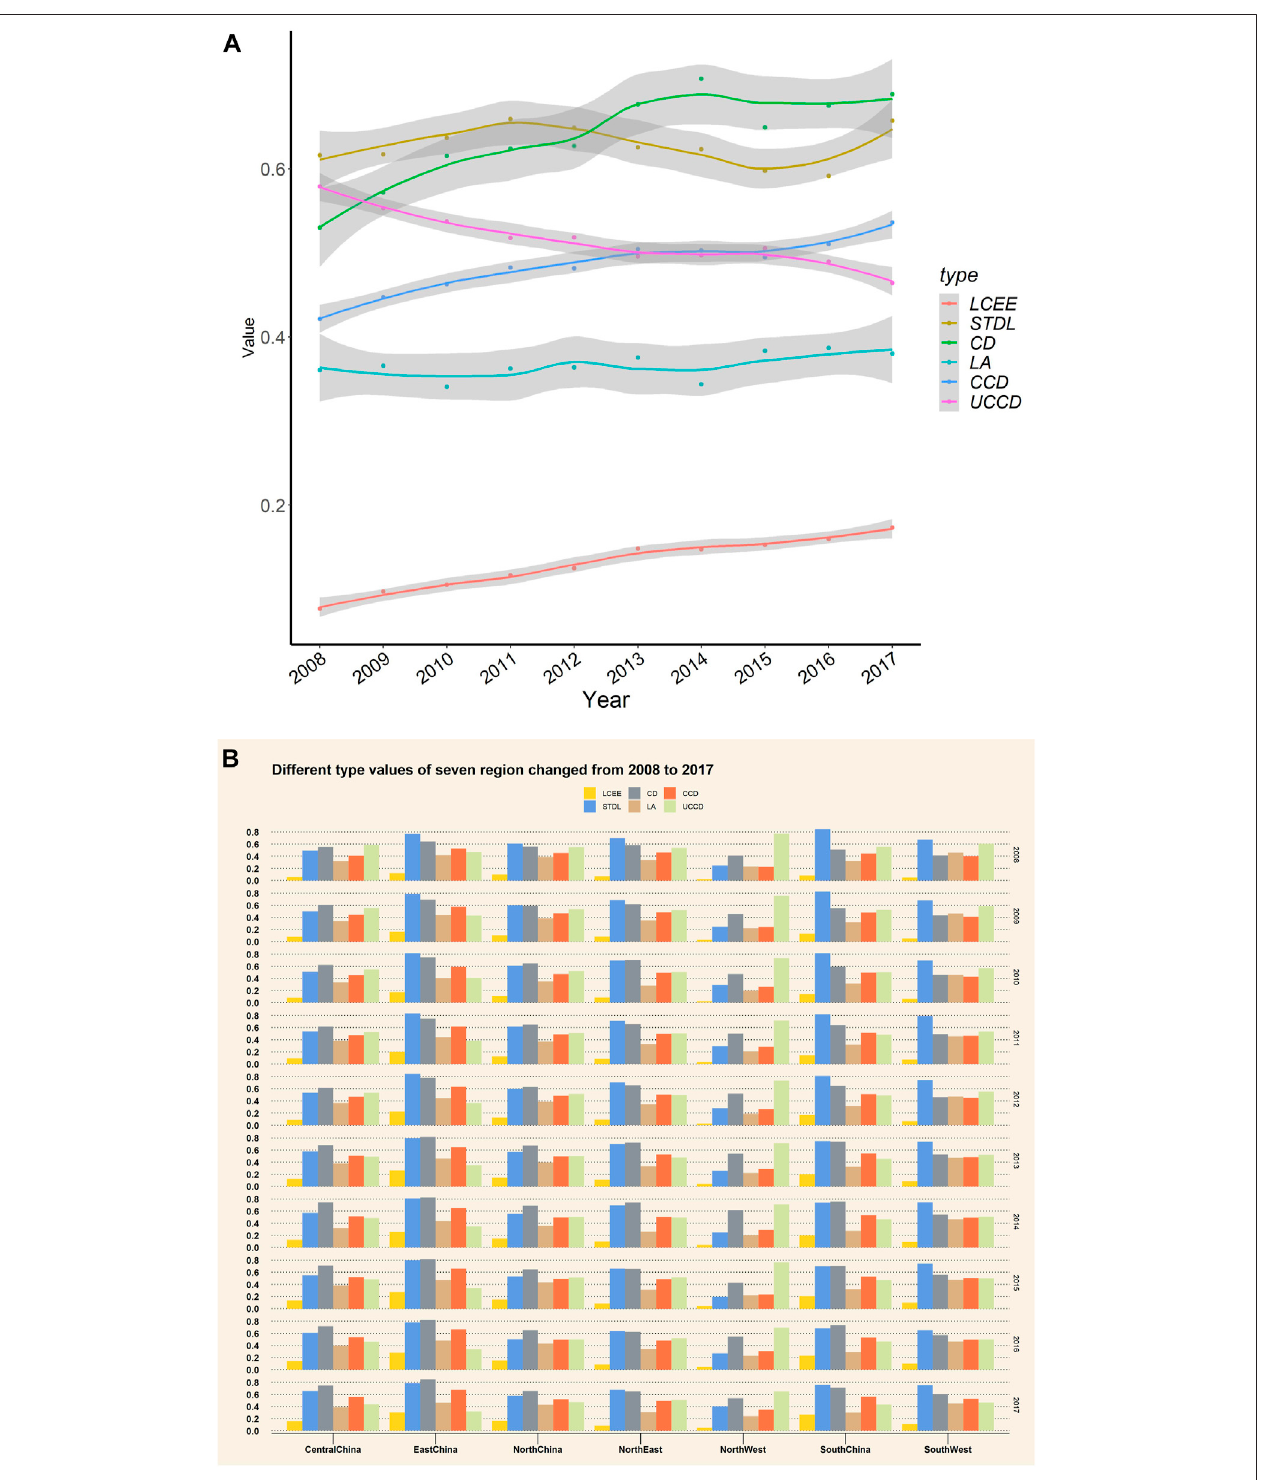
FIGURE 1 | (A) Time series changes of the LCEE and STDL indices and the UCCD. (B) . Diffrent type values of seven region changed from 2008 to 2017.